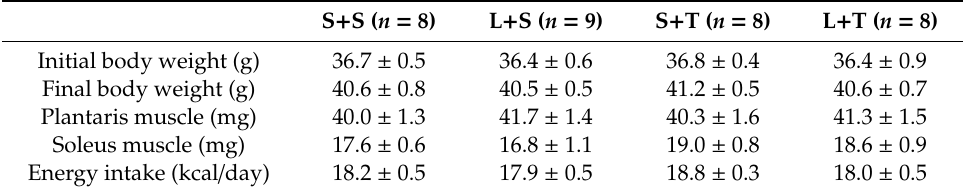
Table 1. Initial and final body weights, soleus muscle weight, plantaris muscle weight, and energy intake in 4-week ingestion experiment.